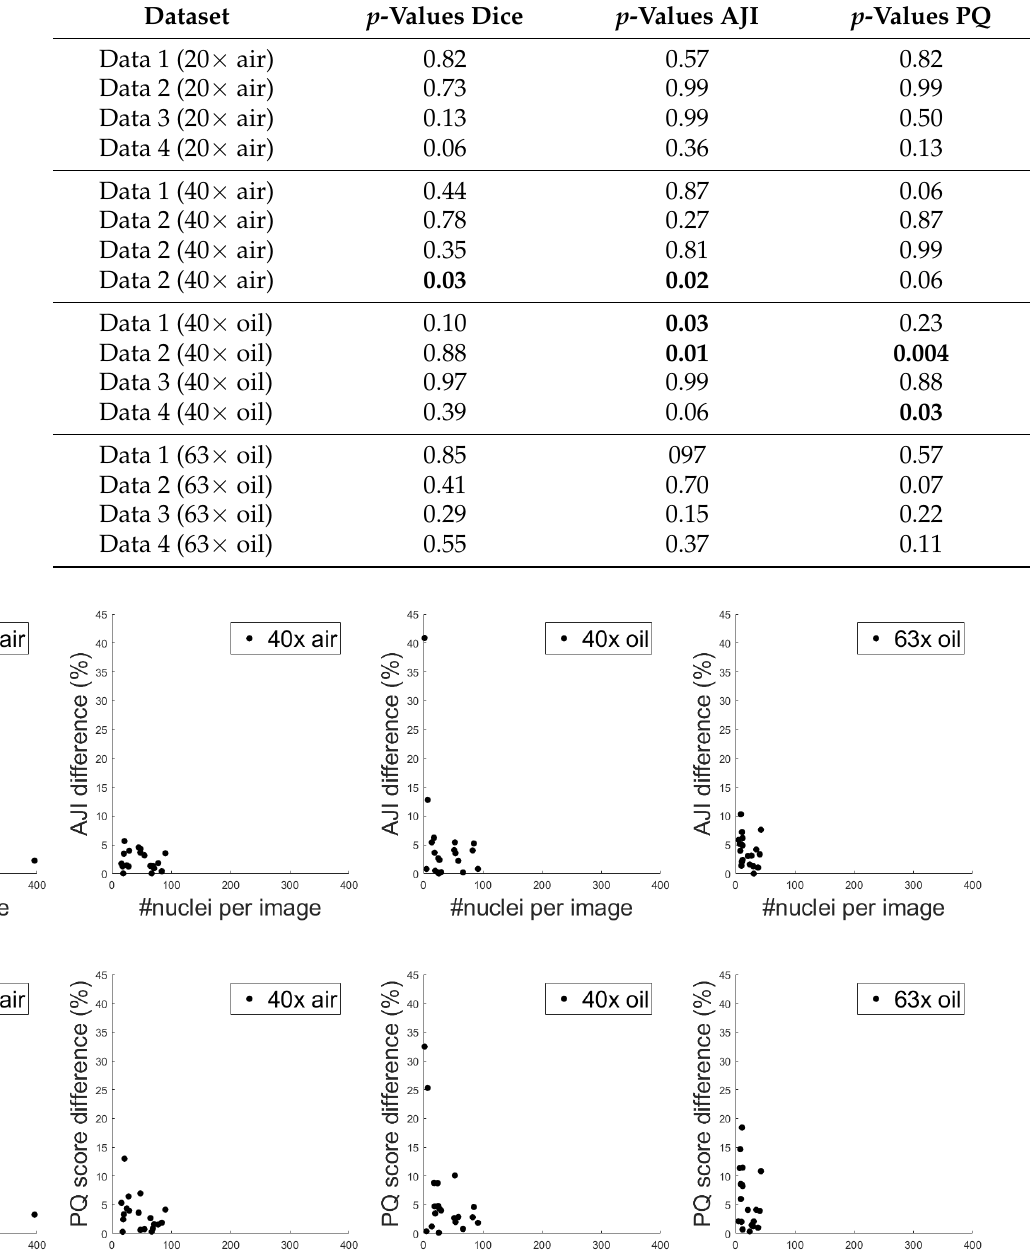
Table 3. Derived p -values from comparing 8 bit and 16 bit images of the BitDepth dataset. p -values < 0.05 are shown in bold in accordance with the results of Table 2.